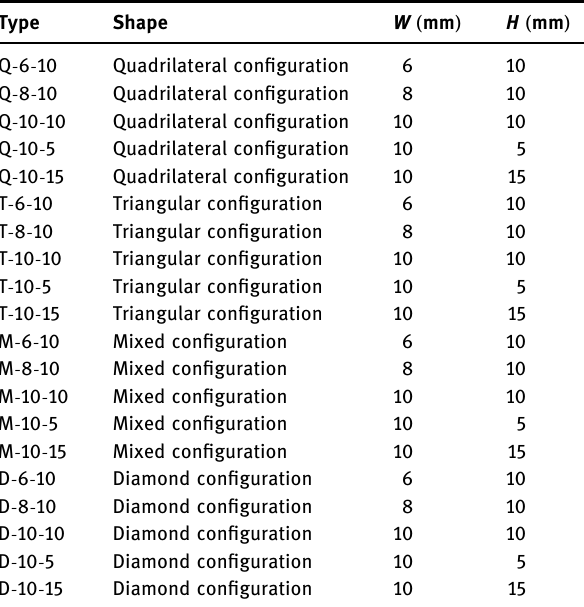
Table 1: Classi fi cation and size of composite grid sandwich structure